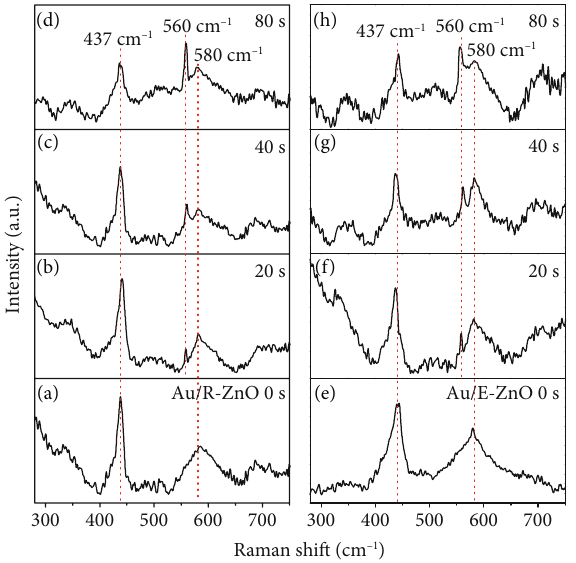
Figure 4: (a – h) Raman spectra of Au/R-ZnO and Au/E-ZnO nanocomposites with di ff erent loading Au NPs (0 s, 20s, 40s, and 80s),